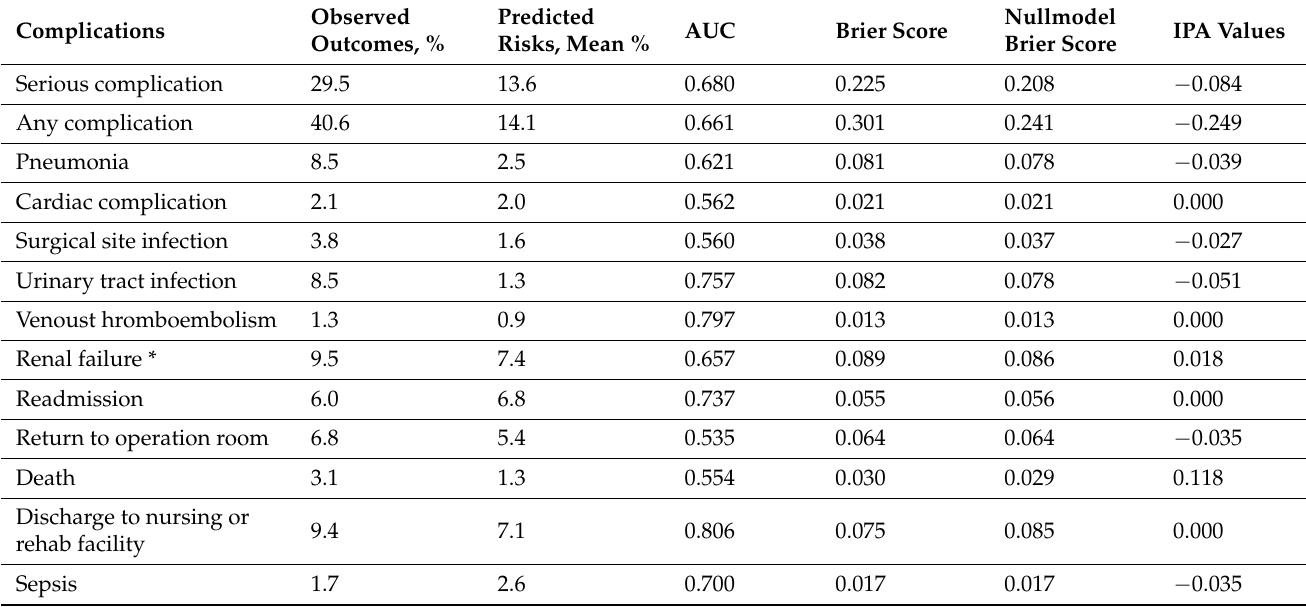
Table 2. Comparison of observed outcomes to ACS calculated risks.